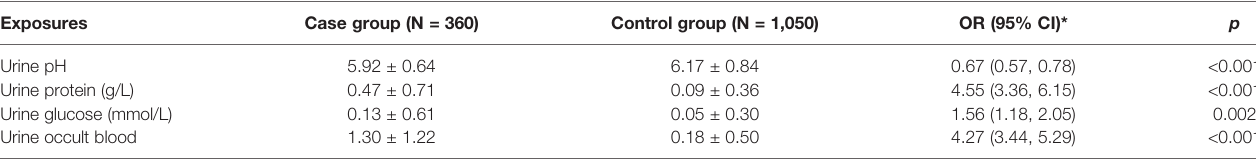
TABLE 2 | Univariate conditional logistic regression for urine